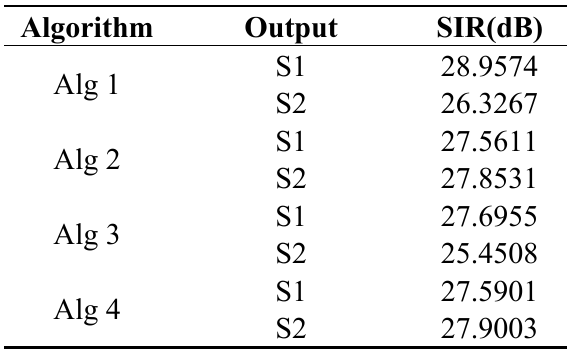
Table 1. Comparison of the performance of extracting two sources of interest by using the algorithm of Alg 1, Alg 3, Alg 3 and Alg